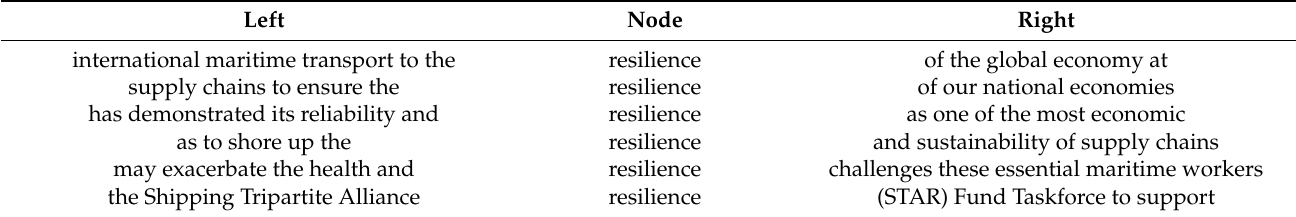
Table 8. The keyword resilience in circular